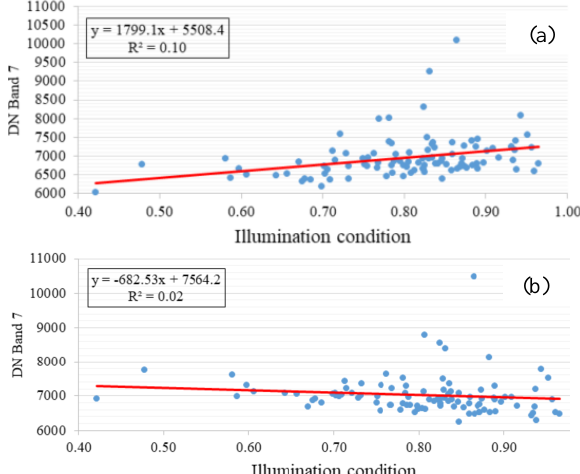
Figure 9. Reflectance of band 7, (a) before and (b) after topographic correction